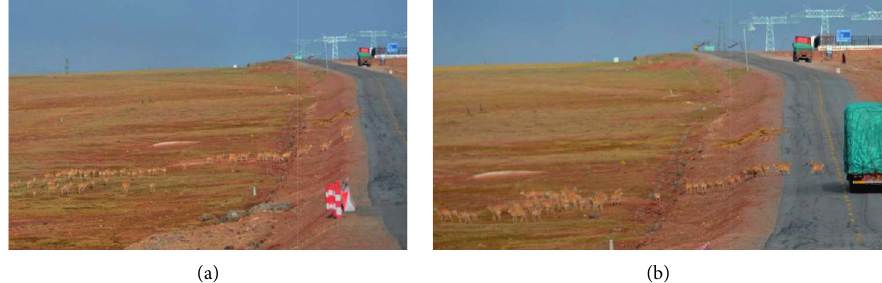
Figure 5: Tibetan antelope population: (a) trying to cross the highway and (b) failing to cross the highway due to traffic interference.